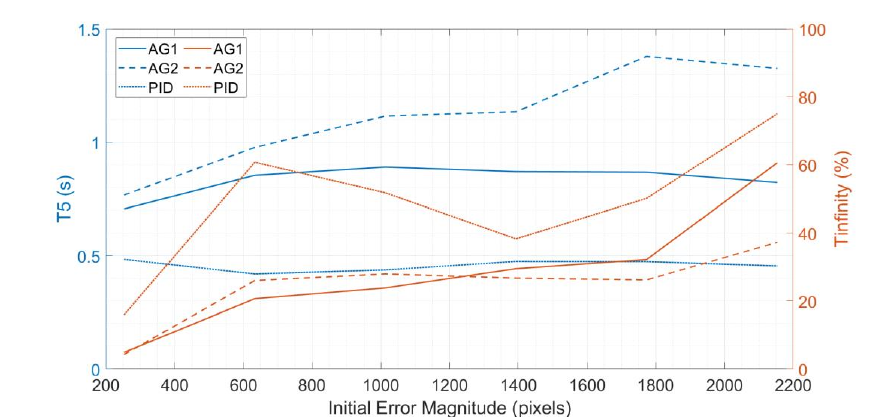
Figure 10. Evolution of t 5 % and t ∞ response times versus initial error magnitudes for PID, AG1, and AG2 control